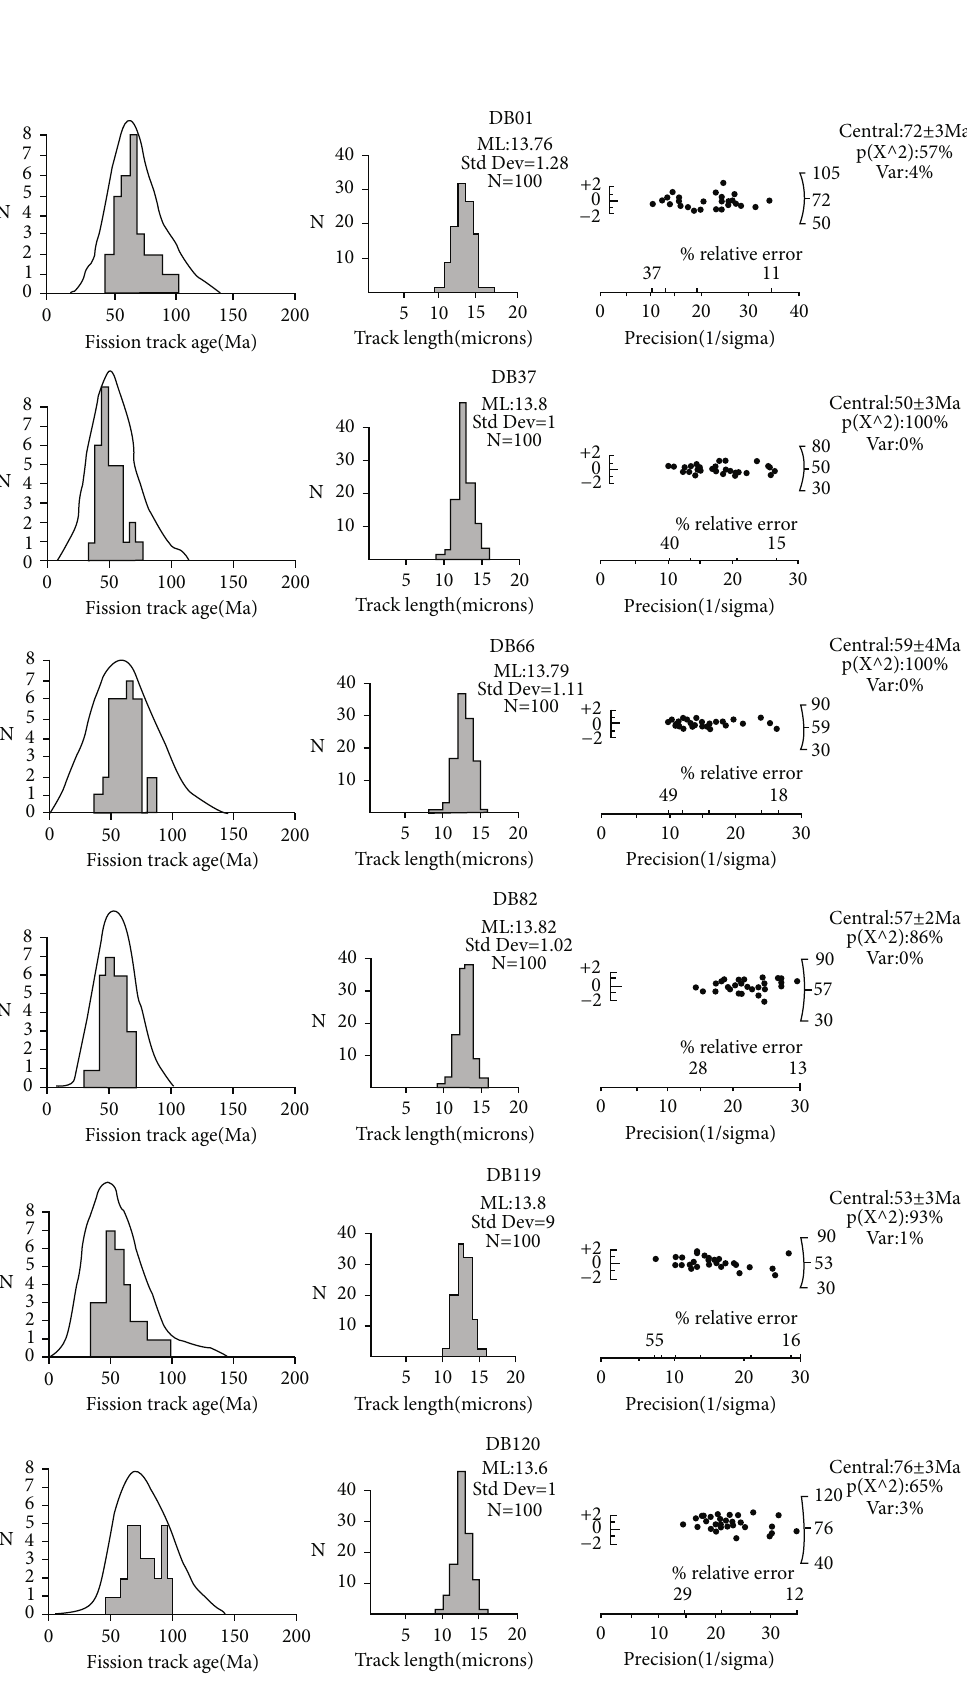
Figure 4: Single grain age histograms, AFT length histograms and radial